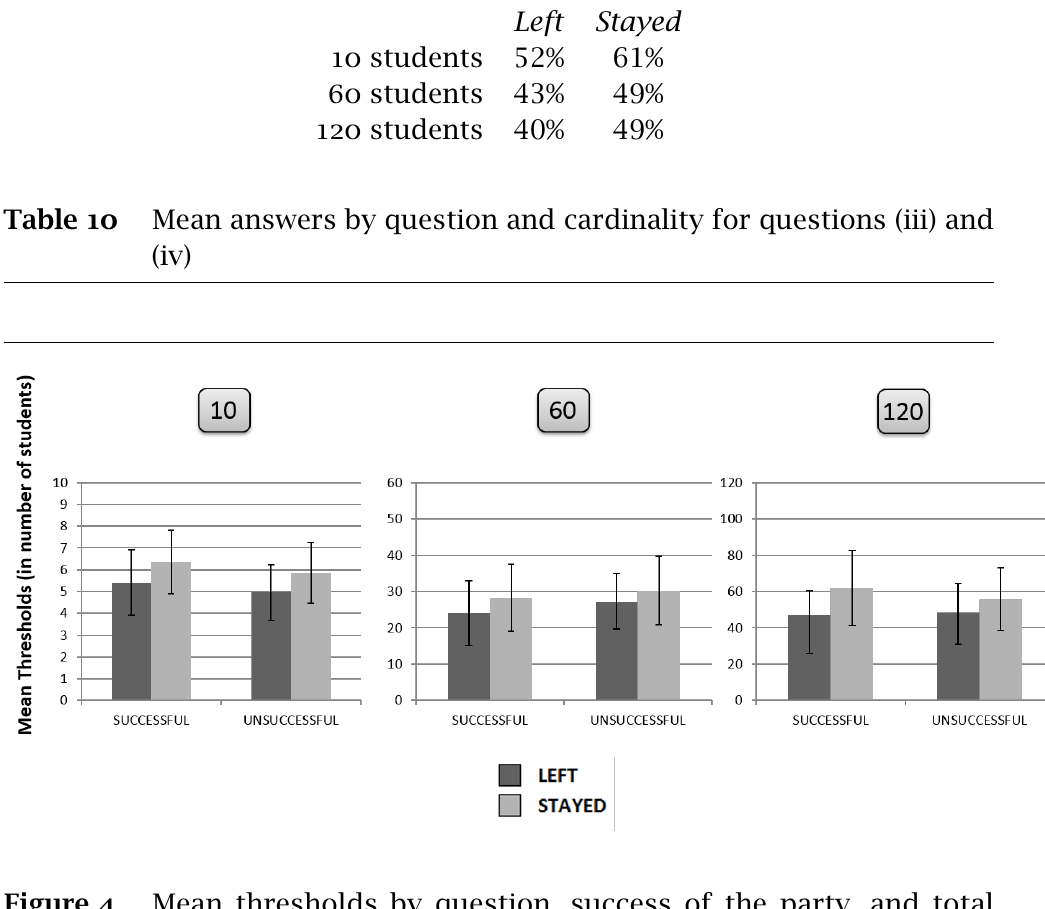
Figure 4 Mean thresholds by question, success of the party, and total number of students. Error bars indicate standard